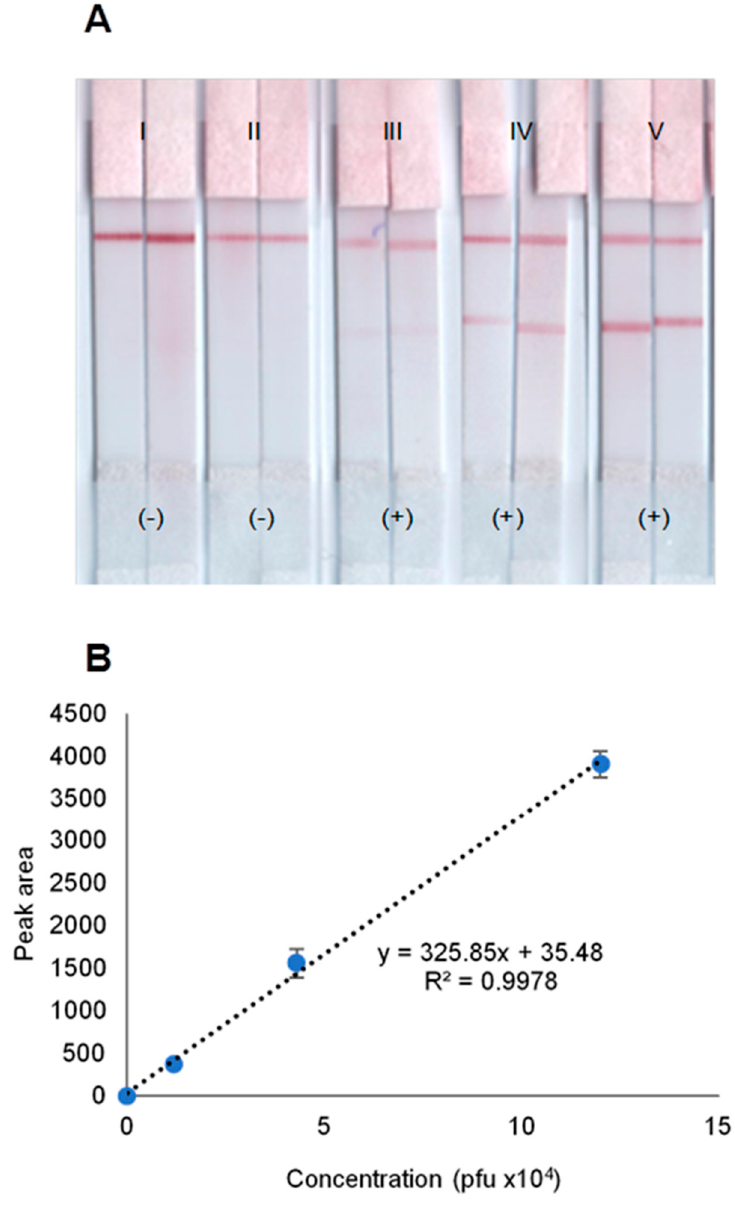
Figure 6. ( A ) Photo images of replicate LFB strips tested with NASBA products showing ( − ) results for water (I) and pooled human sera (II), but ( + ) results for DENV-1 in pooled human sera at 1.2 × 10 4 (III), 4.3 × 10 4 (IV) and 1.2 × 10 5 pfu / mL (V), and ( B ) their corresponding dose–response curve.